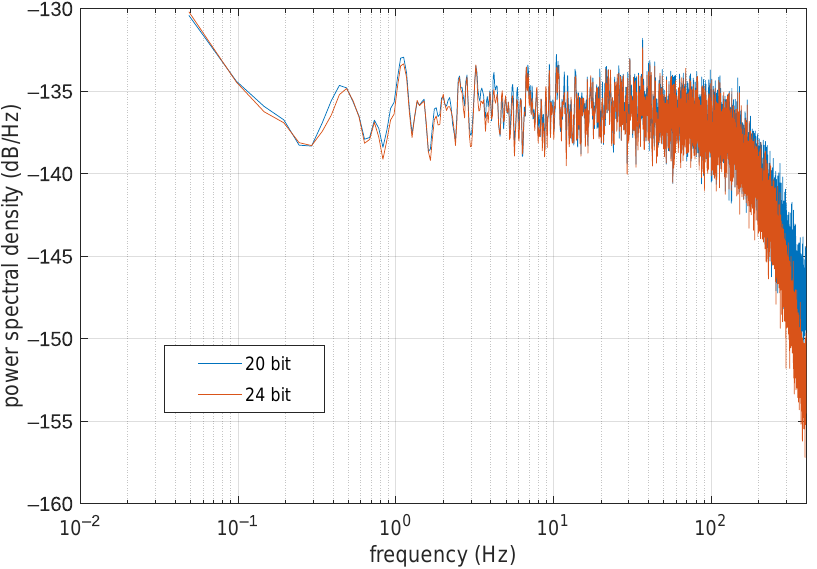
Figure 4. Noise floor vs. number of bits at the output of the